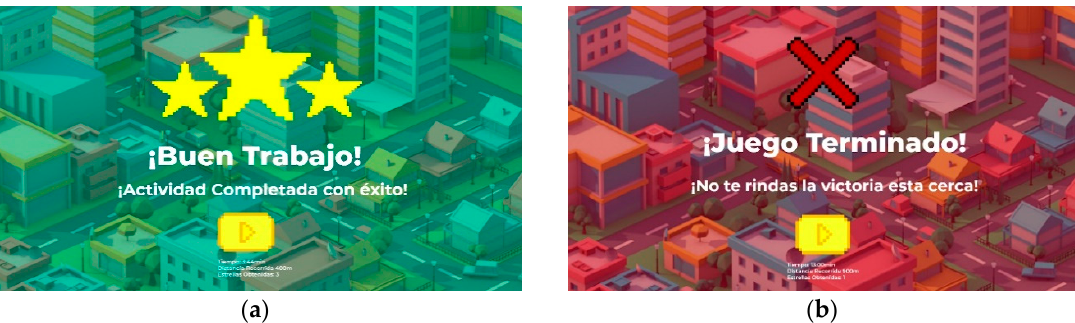
Figure 10. ( a ) Stars awarded upon arrival at your destination and a motivational message. Good job, activity successfully completed (“Buen Trabajo! Actividad completada con éxito!”). ( b ) Screen displayed when you fail to reach the destination and you are encouraged to keep trying. Don't give up! victory is near! (“¡Juego terminado! ¡No te rindas la Victoria esta cerca!”). To select the mechanics and dynamics, the gamification techniques selection process shown in Section 2 was followed, as described in the following section.